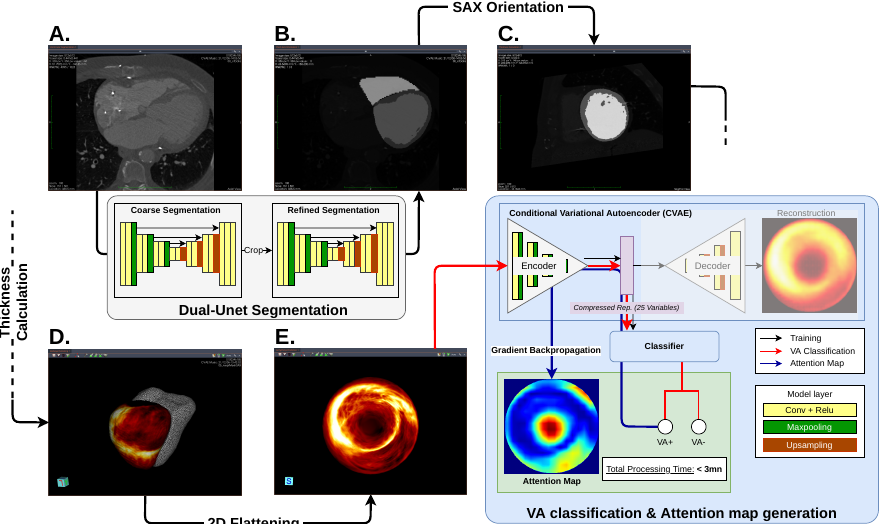
Figure 11. Automatic pipeline for LV (left ventricular) wall thickness map extraction and VA predic- tion. The arrows illustrate the background calculations and AI predictions. ( A ) Input 3D CT image, ( B ) segmentation masks, ( C ) short-axis oriented masks, ( D ) 3D wall thickness map, ( E ) 2D bullseye thickness